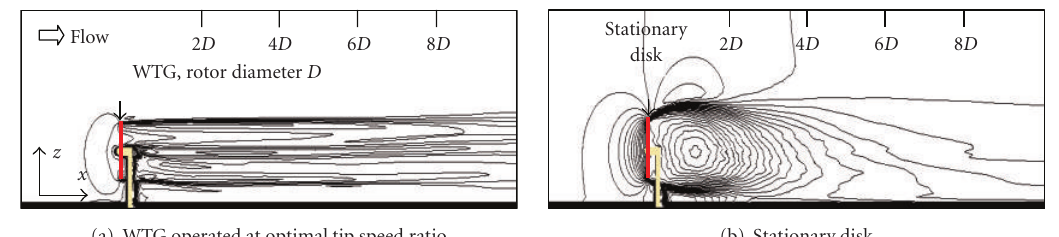
Figure 11: Same as Figure 10 except for side view of the entire domain at y = 0.